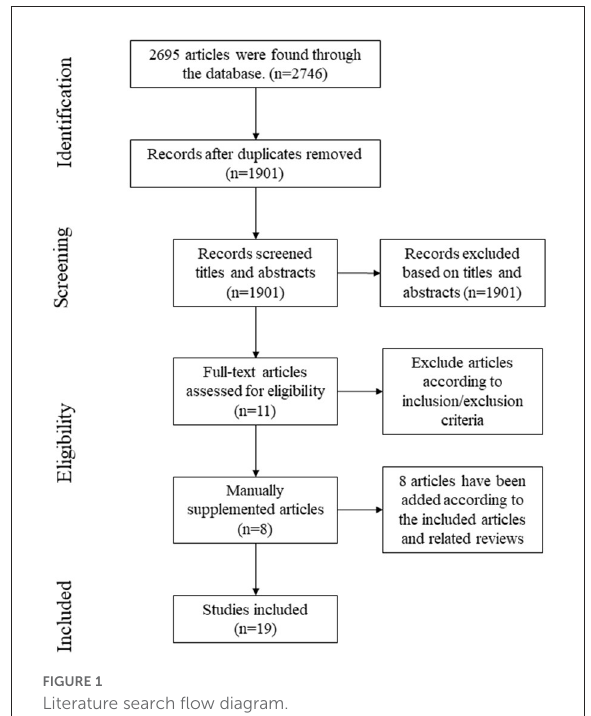
FIGURE1 Literature search flow